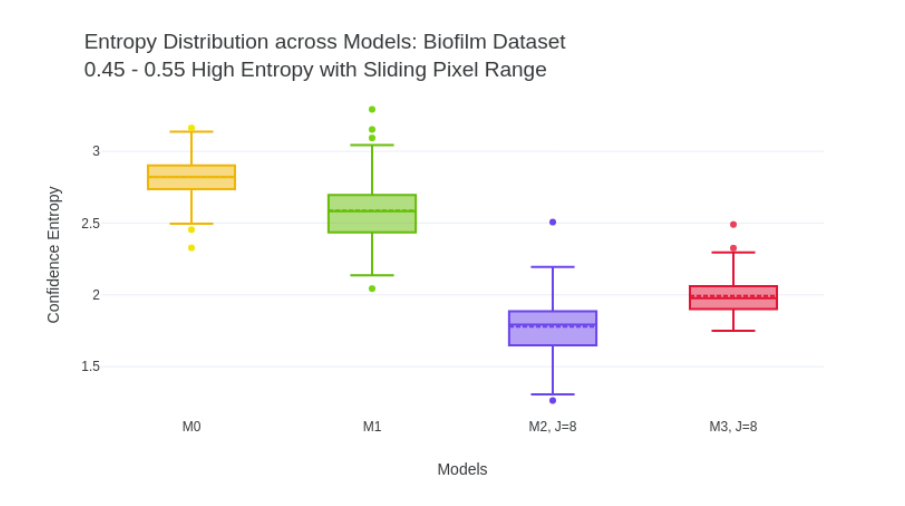
Figure 10. Entropy distribution across